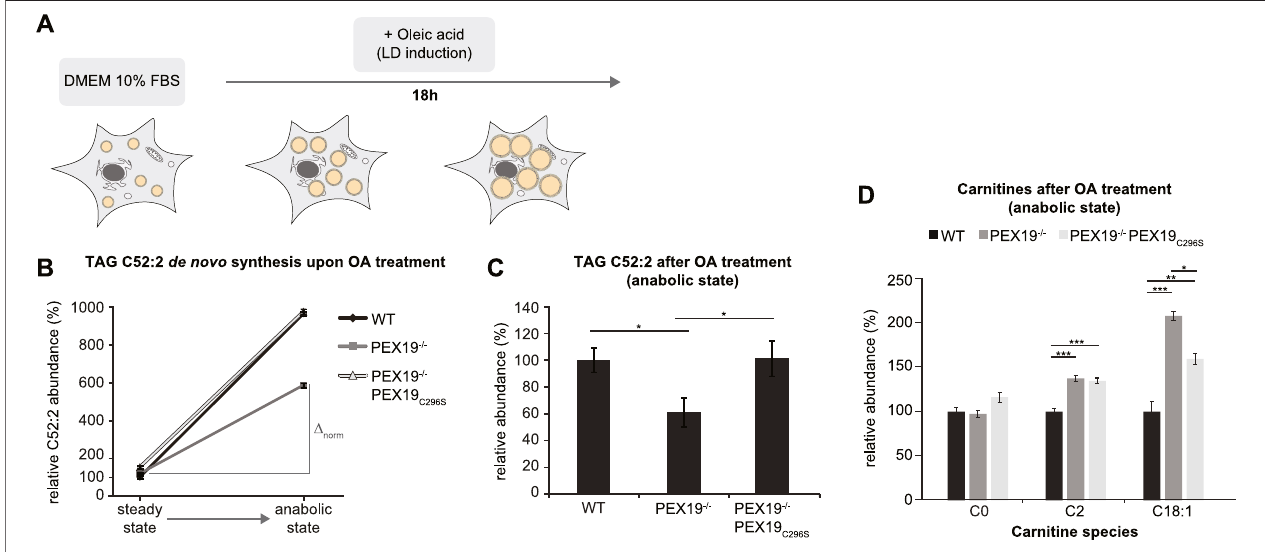
FIGURE4| Denovo TAGsynthesisisnotcompromisedinPEX19 − / − PEX19 C296S cells. (A) Schematicoutlinedepictingthatcellswereshiftedtoanabolicconditions by incubation in DMEM medium containing 10% FBS and oleic acid (OA) for 18 h. (B,C) Shotgun-lipidomics results for TAG C52:2 species upon OA treatment. (B) Plot indicating TAG de novo synthesis upon OA treatment for WT, PEX19 − / − and PEX19 − / − PEX19 C296S cells using C52:2 as a metric (Starting points = steady state; endpoints = anabolic state). Values were normalized to 100% in WT cells under steady state conditions before OA treatment. Relative C52:2 de novo synthesis as fold change is de fi ned by the ratio between C52:2 levels under anabolic condition and C52:2 levels at steady state before OA treatment and is 9.6 for WT, 4.9 for PEX19 − / − and6.4forPEX19 − / − PEX19 C296S cells. Δ norm indicatestheabsoluteC52:2synthesisasde fi nedbythedifferenceofC52:2levelsunderanabolicconditionsand C52:2 levels at steady state before OA treatment for each cell line and is 864 for WT, 467 for PEX19 − / − and 823 for PEX19 − / − PEX19 C296S cells (C) Bar diagram showing the relative abundance of TAG C52:2 species accumulating after OA treatment in WT, PEX19 − / − and PEX19 − / − PEX19 C296S cells. Values were normalized to 100% in WT cells. (D) Bar diagram showing the relative abundance of carnitine species accumulating after oleic acid treatment in WT, PEX19 − / − and PEX19 − / − PEX19 C296S cells. Error barsindicateSEMand statisticalsigni fi cancebetweenthegroupswasdetermined byanANOVA followedbyTukeypost-hoc test. *,**,***indicate p -values < 0.05, < 0.01, and < 0.001, respectively. Non-signi fi cant changes are not indicated. For each cell line 5 individual samples were analyzed with three technical replicates